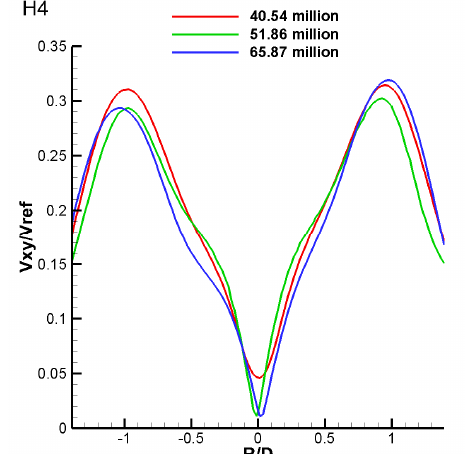
Figure 9. Grid independence.